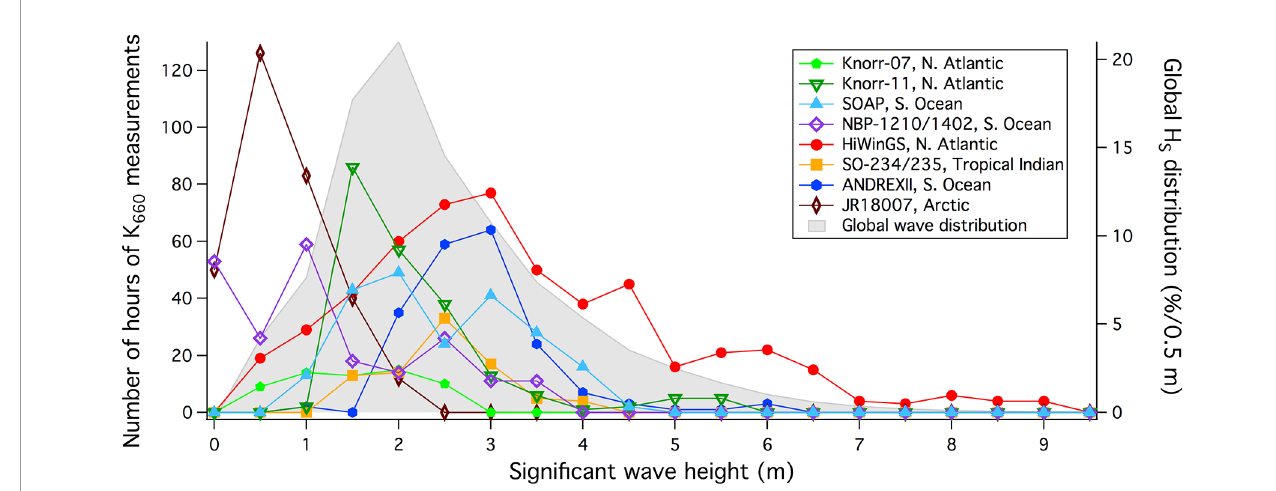
FIGURE 5 | Hours of K 660 measurements at different signi fi cant wave heights and the global distribution of signi fi cant wave height from